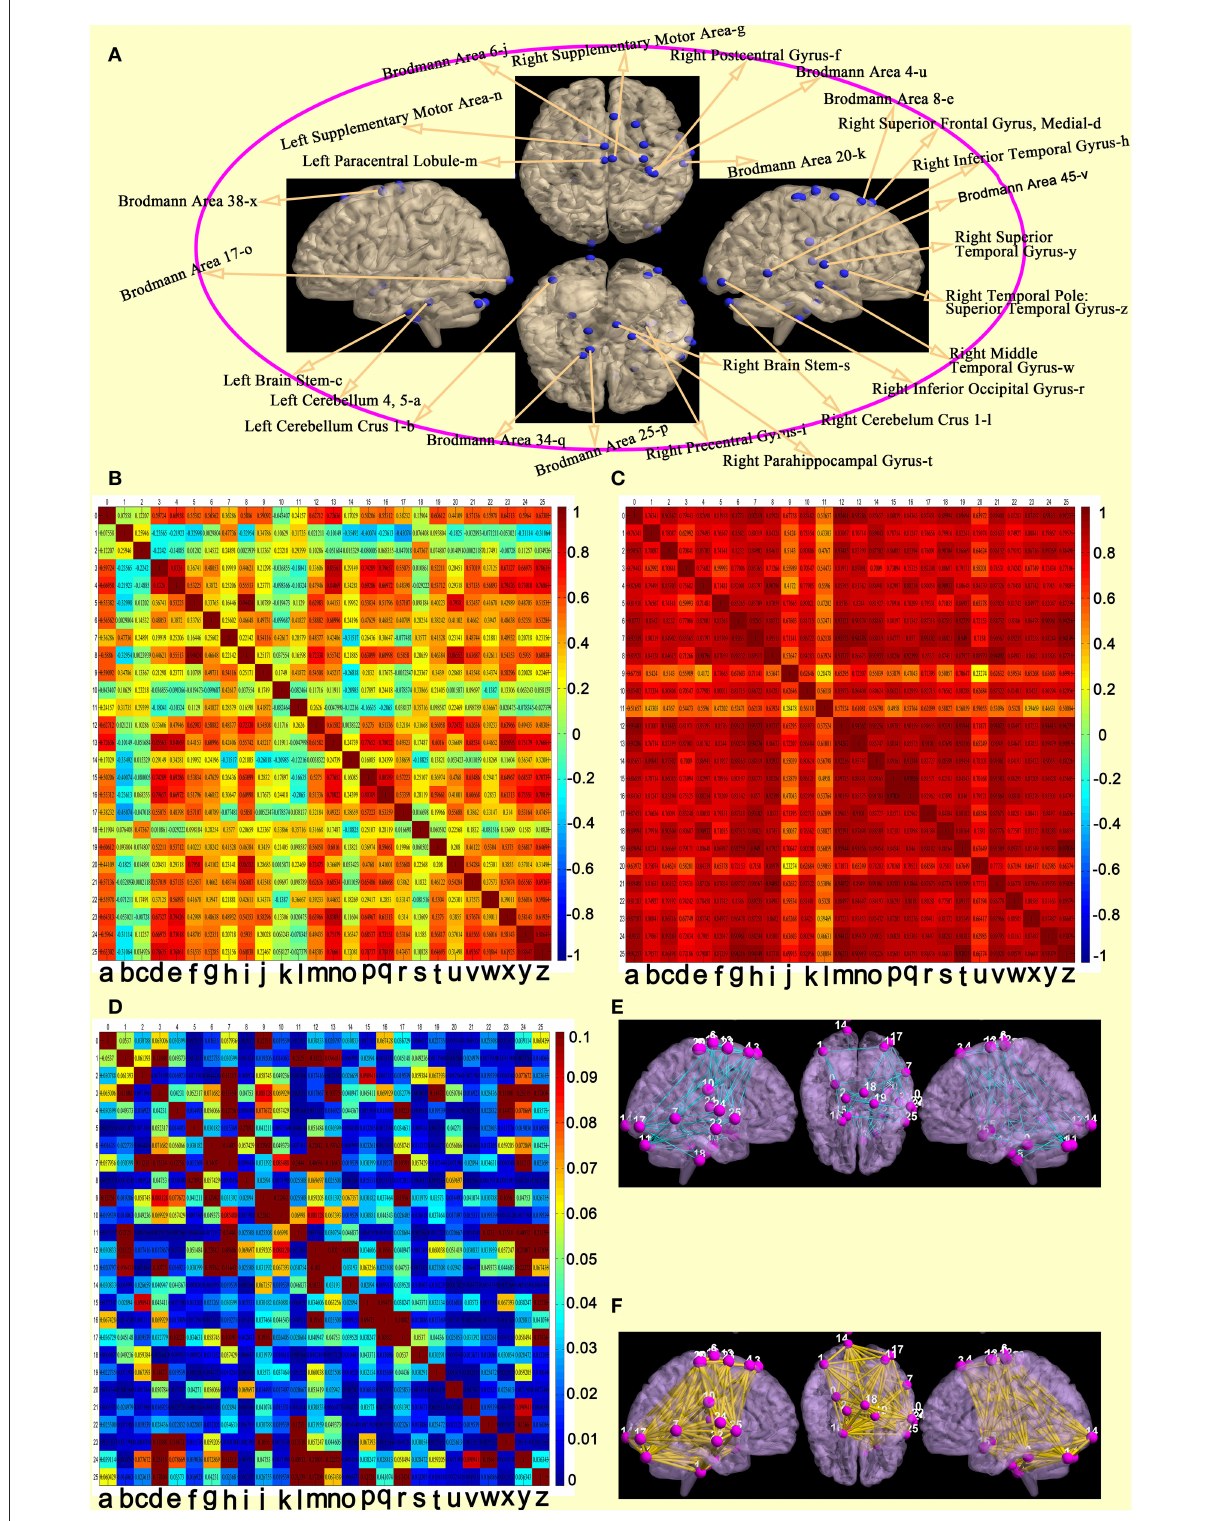
FIGURE4 Features of functional connectivity between each regions of interest pair. (A) 26 regions of interest. (B) matrix of Pearson’s correlation coefficients between each regions of interest pair in the awake group. (C) matrix of Pearson’s correlation coefficients between each regions